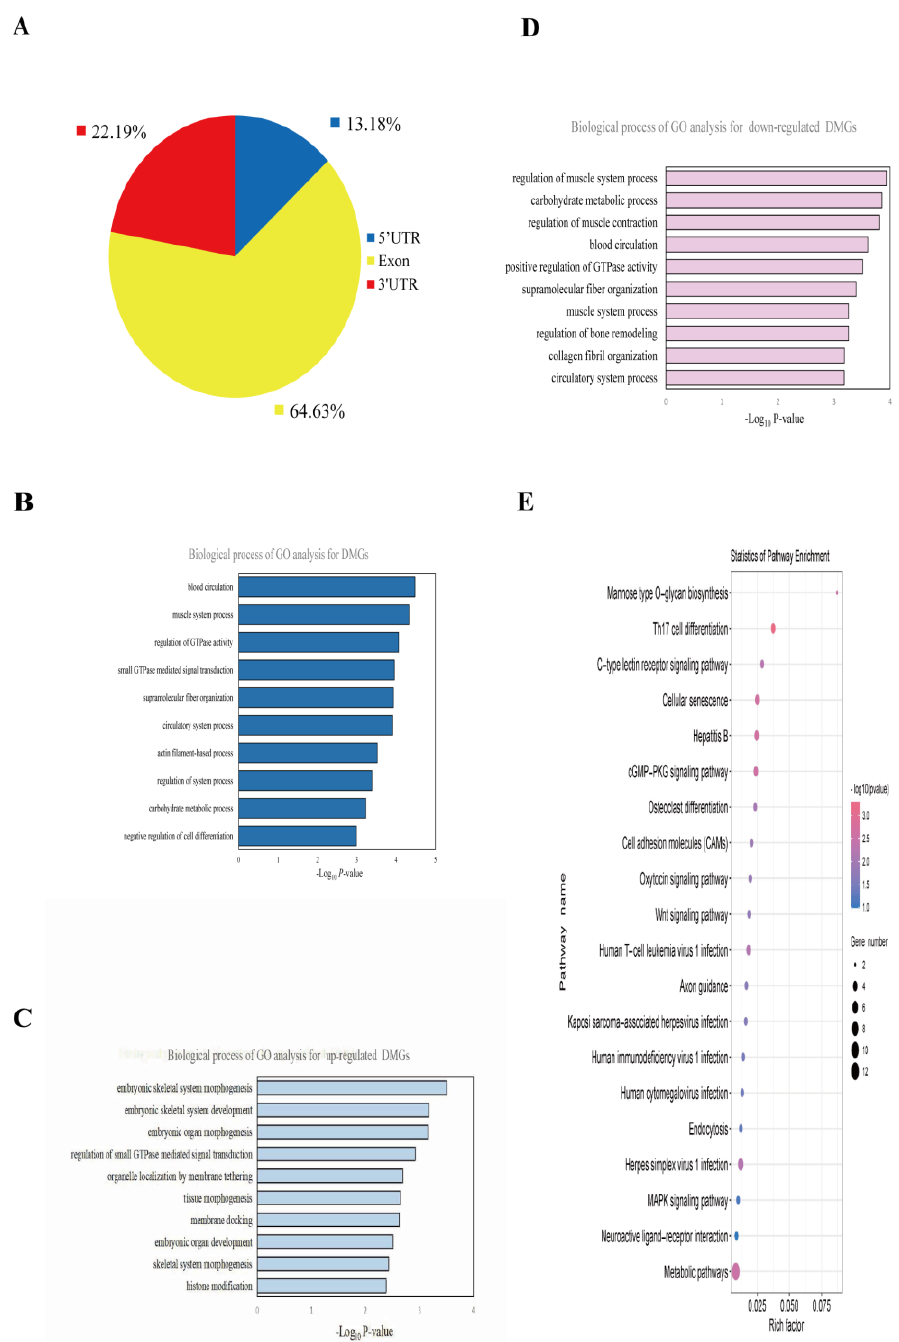
Figure 4. Distribution and functional enrichment analysis of DMGs. ( A ) Distribution of differential methylation peaks. ( B ) GO analysis of differentially methylated genes (DMGs). ( C ) The top ten significantly enriched pathways for the up-regulated DMGs. ( D ) The top ten significantly enriched pathways for the down-regulated DMGs. ( E ) KEGG analysis of DMGs.